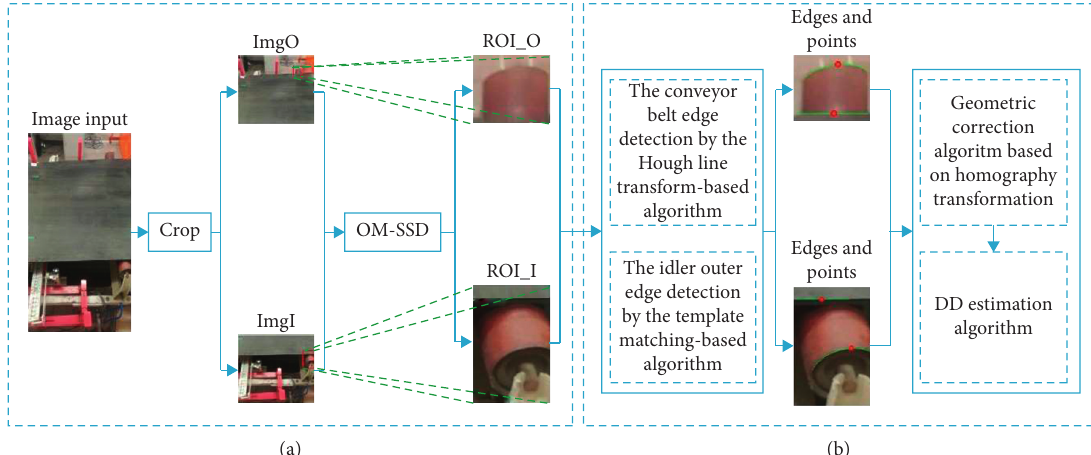
Figure 1: Schematic of the deep-learning-based belt conveyor deviation detection method. The inspection robot captures an image and divides it into imgO and imgI; then, they are input into the ROI detector (OM-SSD) to extract the ROI_O and ROI_I, respectively. The ROIs are converted into gray images, and then, the conveyor belt edge detection algorithm and the idler outer edge detection algorithm are implemented on them to get the edges. The points are the midpoints of the detected lines representing the conveyor belt edges and the vertices of the idler outer edges, respectively. The coordinates of the points are corrected by the geometric correction algorithm and then used to estimate the DD. The distances between the two points in ROI_O and ROI_I represent the lengths of the exposed outer and inner idler, and the difference between the lengths indicates the DD. (a) Phase 1: ROI extraction. (b) Phase 2: DD